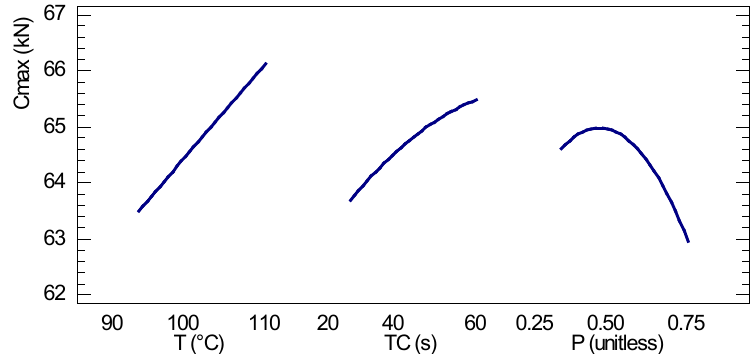
Figure 6. Main effects for maximum compressive strength considering the experimental factors of process temperature, compaction time and proportion of rice husk in the mixture.